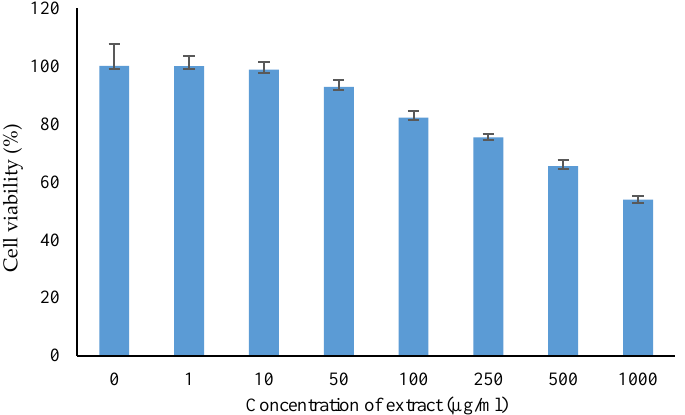
Figure 12. Cytotoxicity of M. oleifera extract on human keratinocytes (HaCaT) cells (in vitro) by MTT assay. All values are mean ± SEM, n = 6.